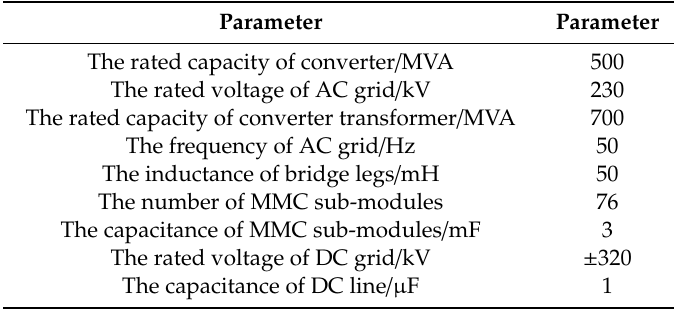
Table 1. The relevant parameters of the DC system.